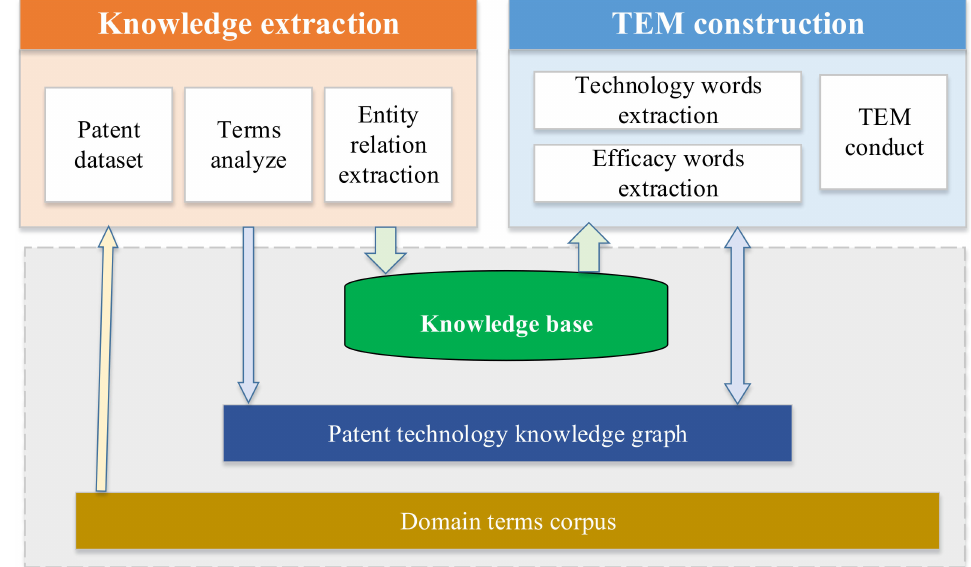
Figure 3. Construction process of the technical efficacy map based on the patent TKG.